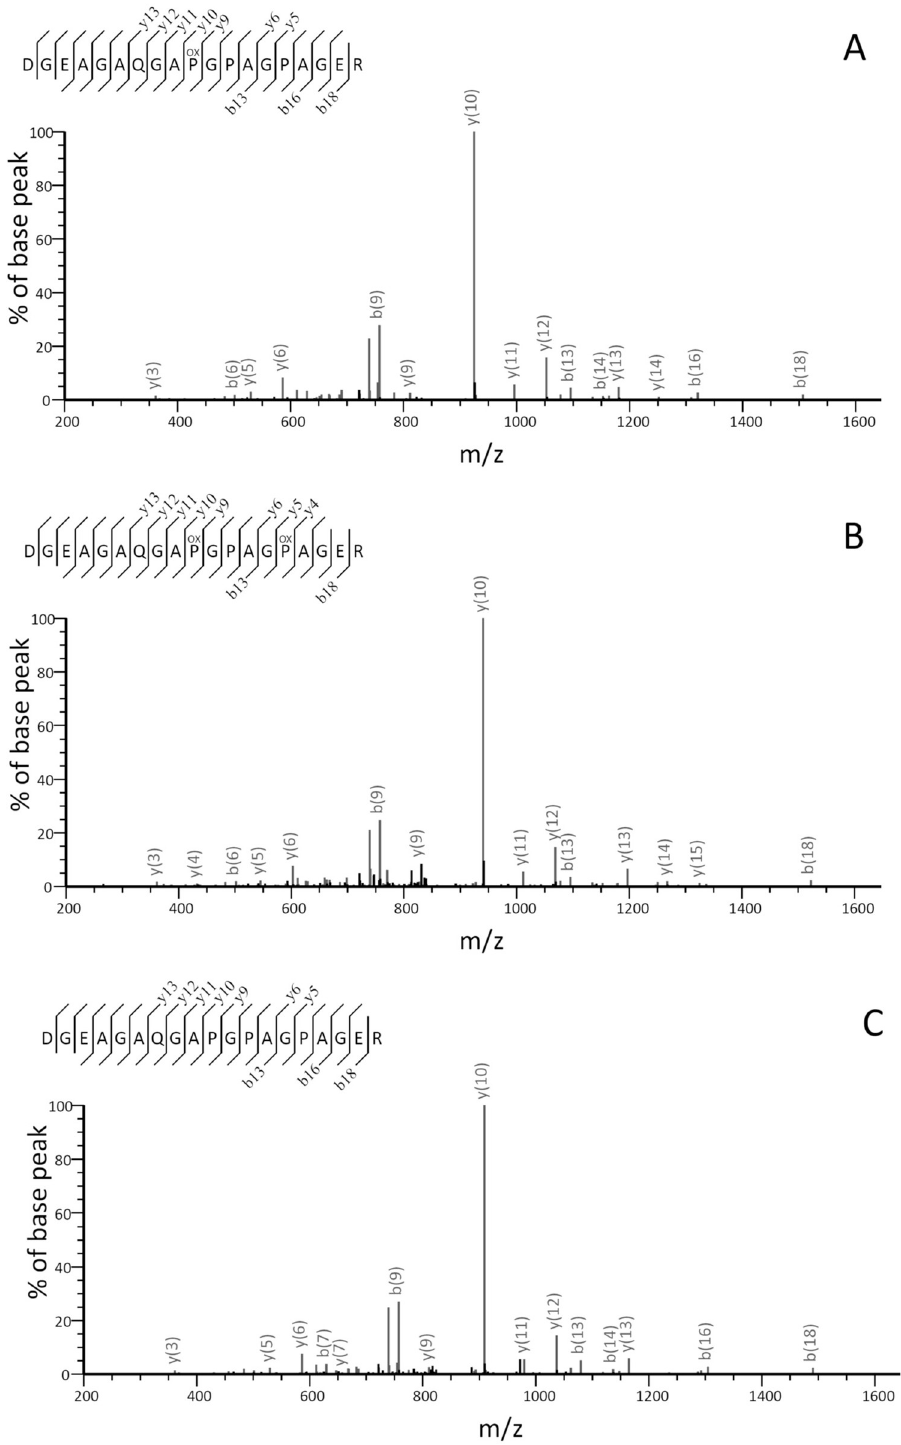
Fig 2. The MS/MS spectra of tryptic peptide 435 dgeagaqgapgpagpager of rat tail tendon α 1(I) chain (lower case stands for the sequence from the genes). Sequencing outcome from ion 840.8832 2+ (1680.7572 + ) (upper panel), ion 848.8801 2+ (1696.7521 + ) (middle panel) and ion 832.8864 2+ (1664.7623 + ) (lower panel). The hydroxylation sites are shown as P OX . For clarity, only selected ions, those most relevant to the identification of residues are labeled.